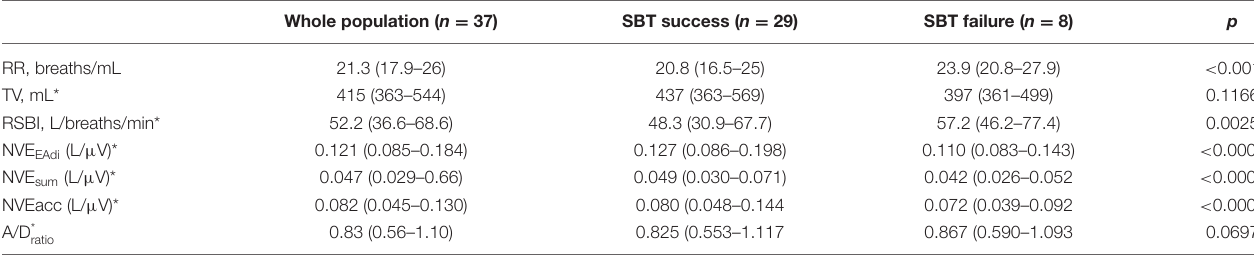
TABLE 2 | Respiratory mechanics variables and neuroventilatory efficiency of diaphragm and accessory inspiratory muscles by weaning success vs. failure during of the SBT.